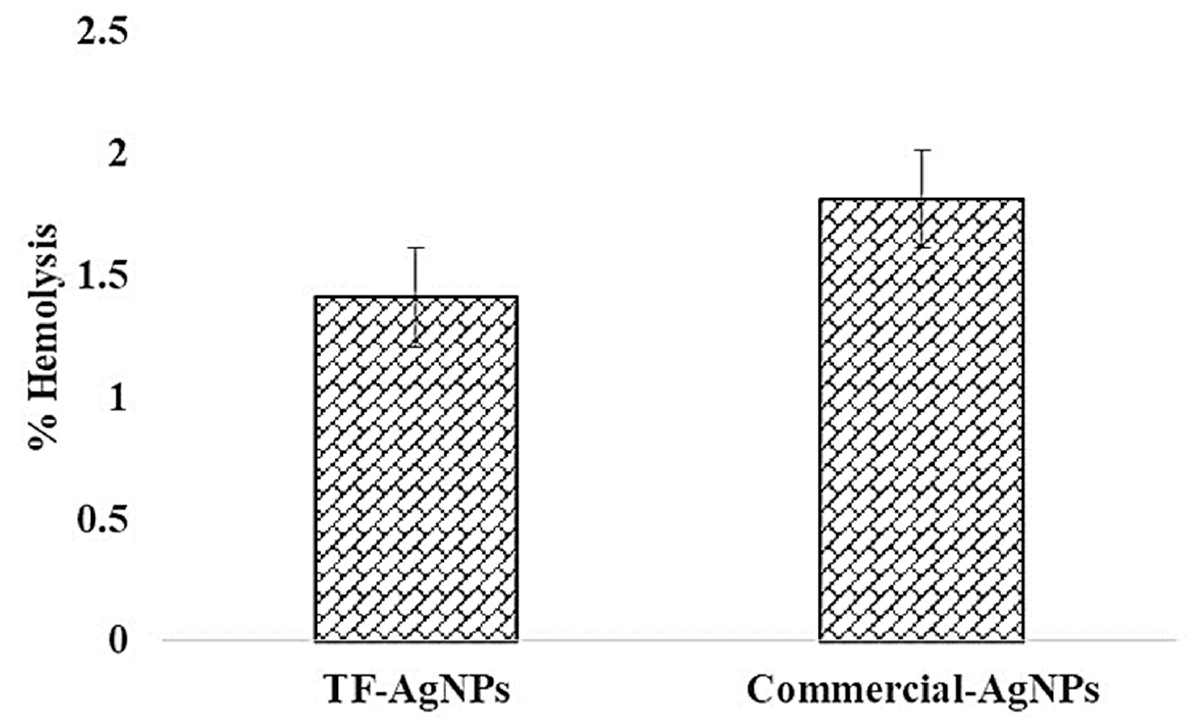
Figure 9. Hemolysis activity of the synthesized T. funiculosus –AgNPs and commercial AgNPs.